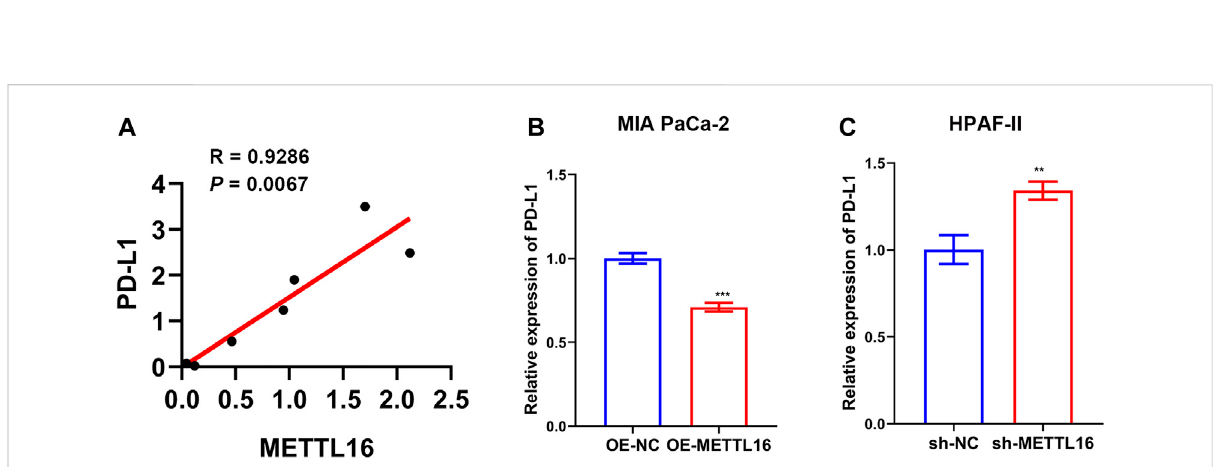
FIGURE 9 Relationship between METTL16 and PD-L1 in PDA. (A) A positive correlation between METTL16 and PD-L1 was observed in PDA clinical specimens by qPCR ( N = 7). (B) Suppression of PD-L1 expression was observed when upregulation of METTL16 expression occurred in MIA PaCa-2 cells. (C) DecreasedexpressionofMETTL16contributedtoenhancedexpressionofPD-L1inHPAF-IIcells.Dataareshownasmean±SD.** p < 0.01,. *** p <